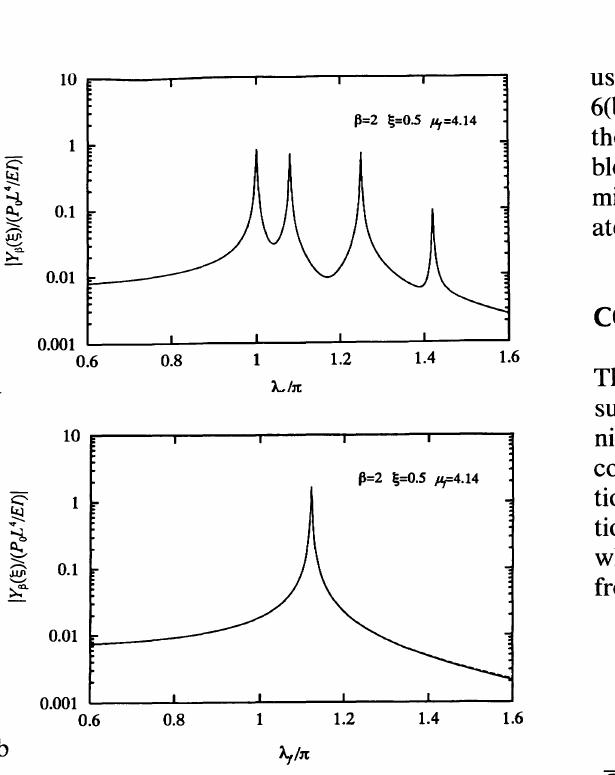
FIGURE 4(a) Nondimensional harmonic response for a four-span beam vs loading frequency parameter 11.[(- Using normal modes of the first band; --- Using normal modes of the first two bands). FIGURE 4(b) Nondimensional harmonic response of an infinitely long mUlti-span beams vs loading fre quency parameter AI (- Using normal modes of the first band; --- Using normal modes of the first two bands).